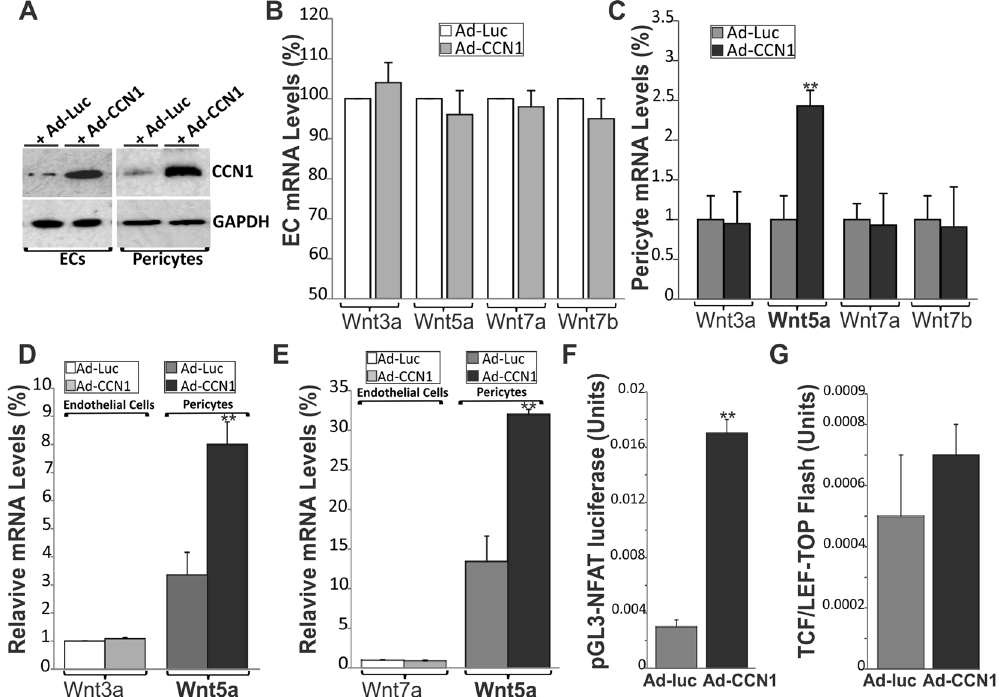
Figure 5. Adenovirus-mediated expression of CCN1 induced Wnt5a expression and activity in cultured pericytes. ( A ) Cultured ECs and pericytes were transduced with an adenoviral vector expressing either luciferase (Ad-luc) or CCN1 (Ad-CCN1). After incubation in serum-free medium for 16 h, cell lysates were analyzed by western immunoblotting for CCN1 protein expression. ( B , C ) Expression Wnt ligands was analyzed by qPCR in Ad-luc- and Ad-CCN1-infected cells. * p < 0.001 versus Ad-luc. ( D , E ) The relative abundance of Wnt5a transcripts and Wnt3a and Wnt7a was calculated by comparing their Δ CTs in pericytes versus ECs. ( F , G ) Effects of CCN1 on canonical and non-canonical Wnt signaling activity. Following adenoviral-mediated gene transfer with either Ad-CCN1 or Ad-luc, cultured pericytes were transiently transfected with either pGL3- NFAT luciferase reporter or LEF/TCF-M50 Super 8 × TOP Flash plasmid. Luciferase activity was determined in cell lysates and media. Values shown are from a representative experiment performed in triplicate. ** p < 0.01 versus Ad-luc. Experiments were repeated three times using different cell preparations with similar